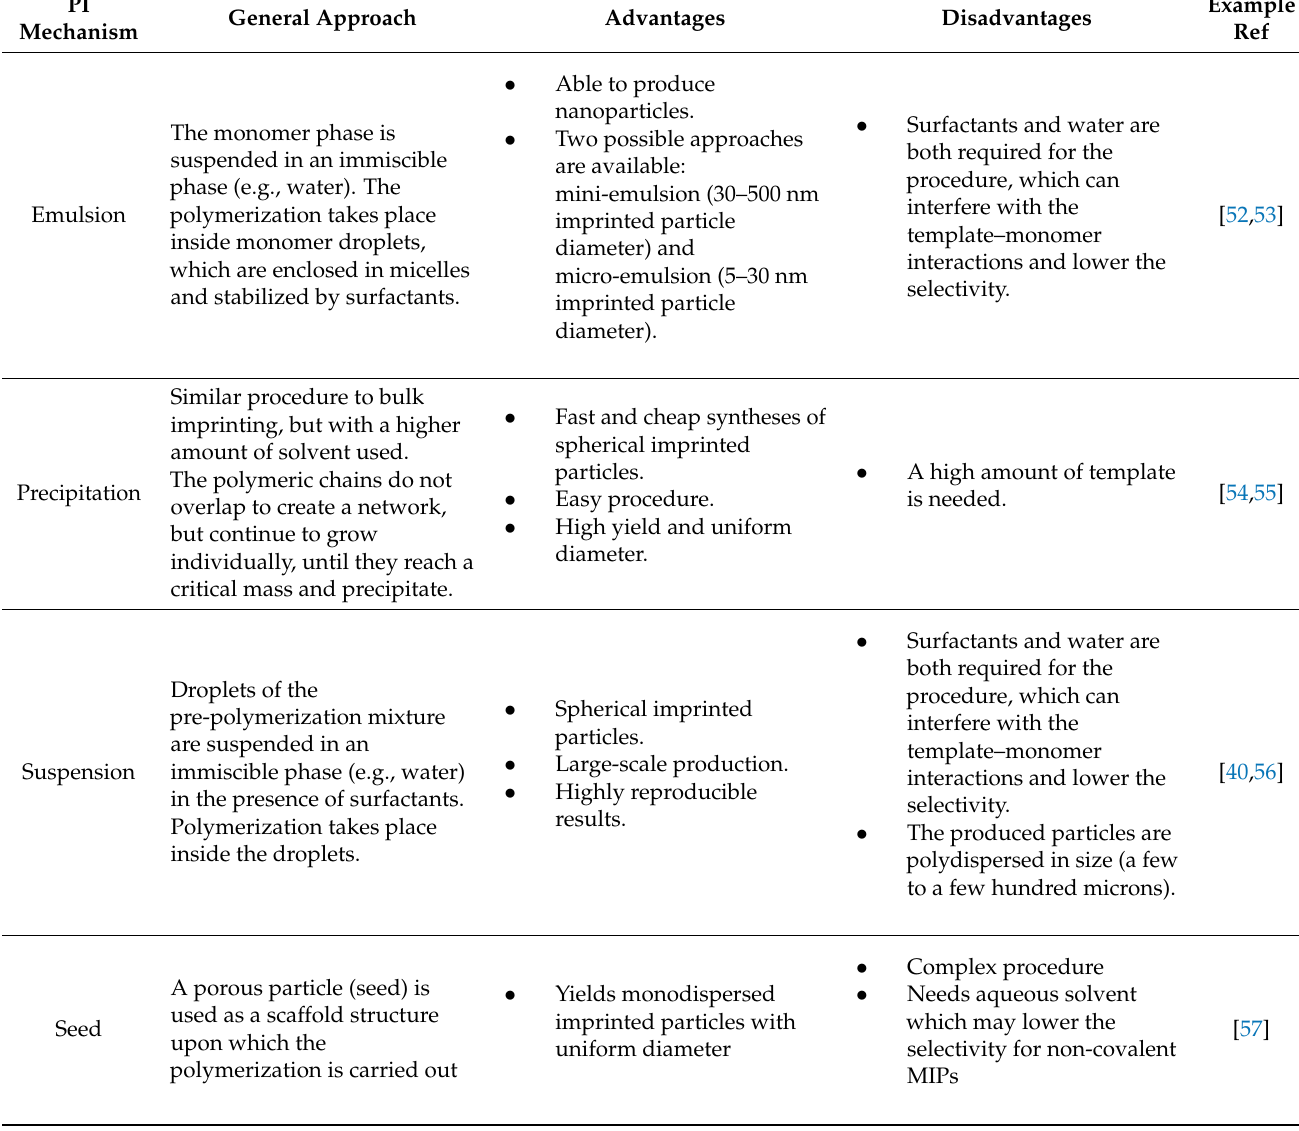
Table 1. Main particle imprinting mechanisms, alongside their advantages, disadvantages and relevant examples from literature.